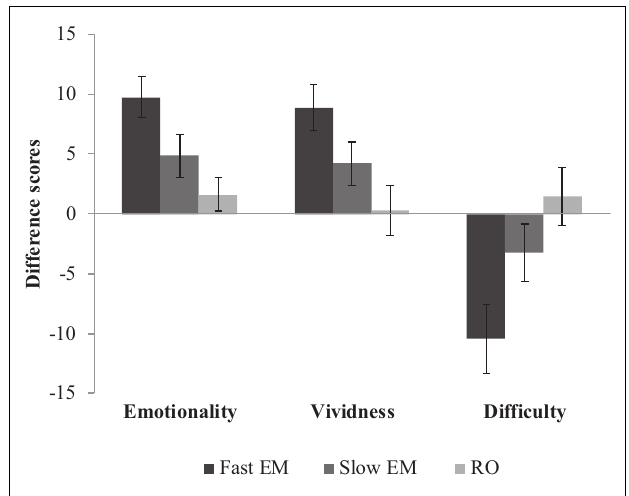
FIGURE 3 | Mean difference scores (post-test minus pre-test) and SEs of fast EM, slow EM, and RO on emotionality, vividness, and difficulty .